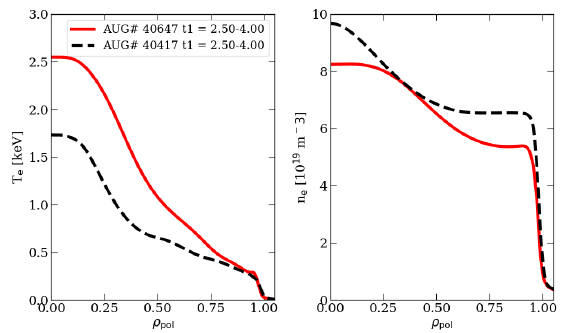
Figure 4. Profiles obtained with integrated data analysis (IDA) for low AUG #40647 and high AUG #40417 pedestal density discharges averaged during time interval t = 2.5 - 4s. Low pedestal density is displayed in red while high pedestal density case is shown in black.